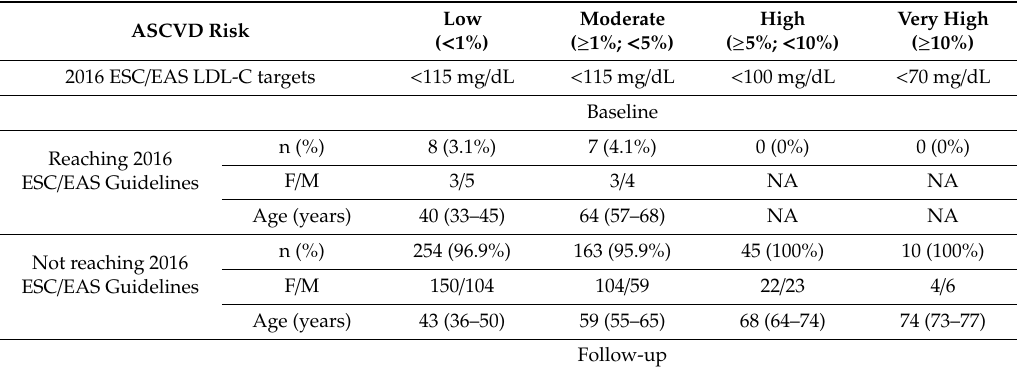
Table 4. Patients reaching and not reaching 2016 and 2019 ESC / EAS LDL-C recommended target in the di ff erent risk